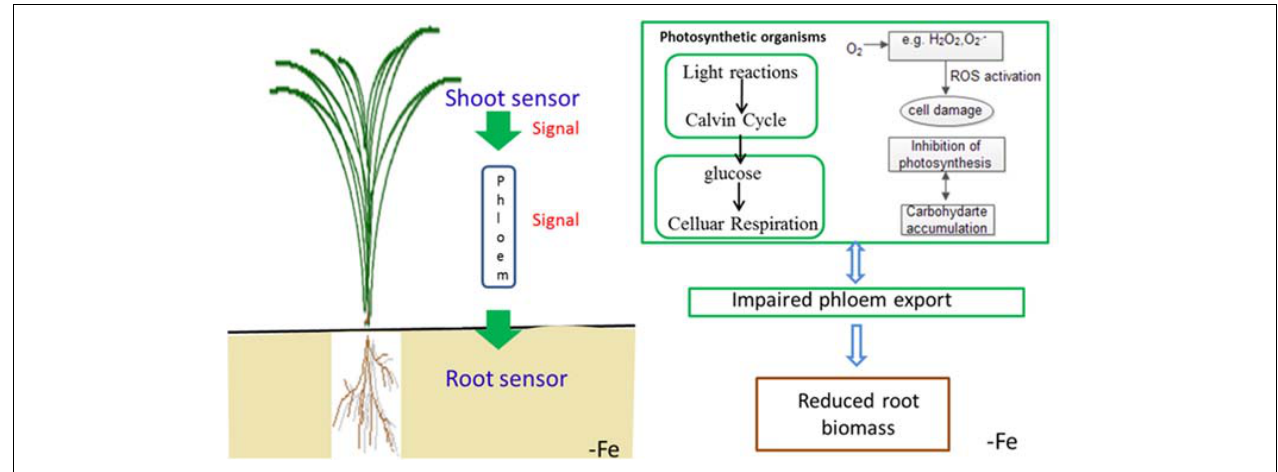
FIGURE 11 | Schematic presentation of changes in signal transduction, photo-oxidative damage and carbohydrate transport in rice under iron deficiency.